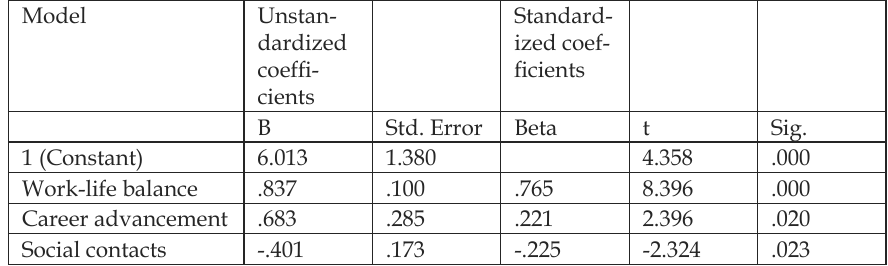
Tab. 14. Predictors of the tendency to leave the organization for the respondents under 35 years. Coef (cid:222)